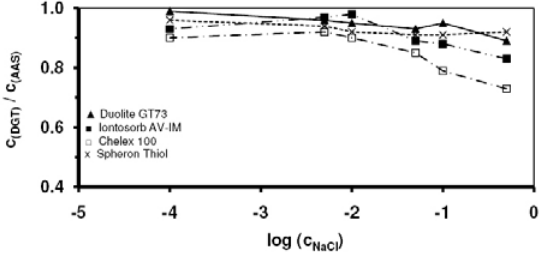
Figure 3. Influence of chloride concentration to measurement of mercury by DGT technique with various sorption gels Table 1.